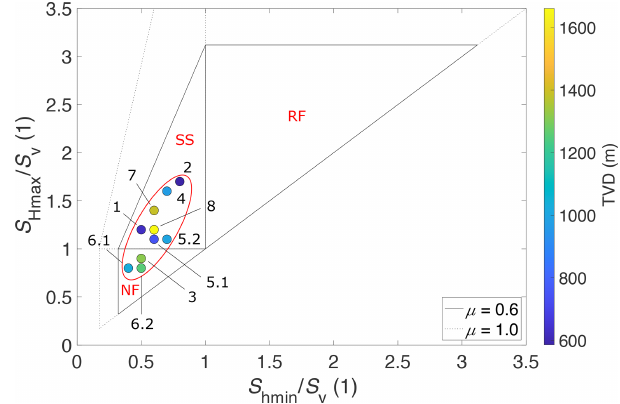
Figure 6. Normalised stress polygon for two different coefficients of friction, µ , of 0.6 and 1.0 with averaged stress magnitude values recorded across the greater Ruhr region (see Table 3 for the actual values) for each test location and depth level (NF – normal faulting, SS – strike-slip faulting, RF – reverse/thrust faulting, TVD – true vertical depth). Numbers correlate to references from Table 3. The stress regime of the study area, based on the collected data within this study, is outlined with a red